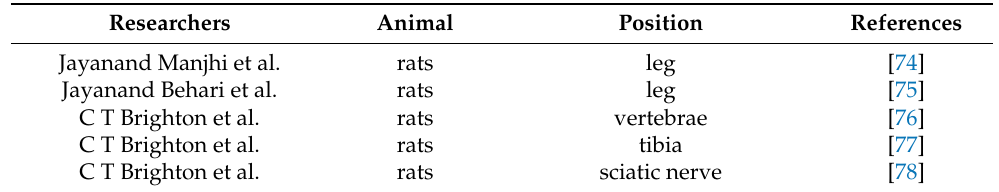
Table 5. Animal experiments using CC for